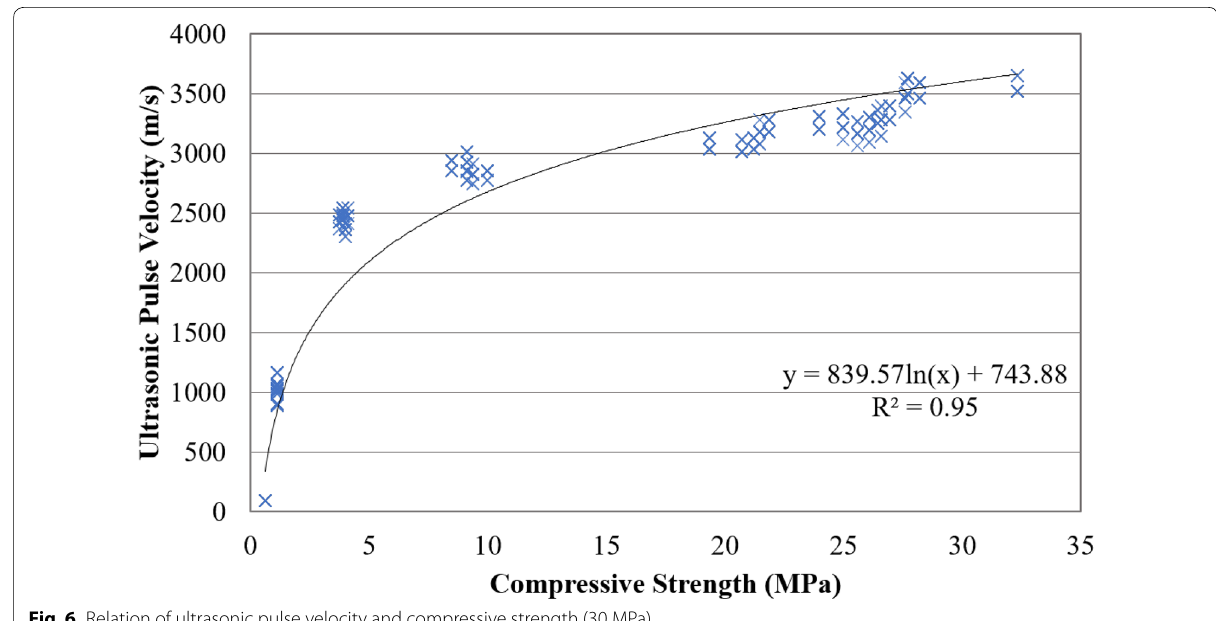
Fig. 6 Relation of ultrasonic pulse velocity and compressive strength (30 MPa)